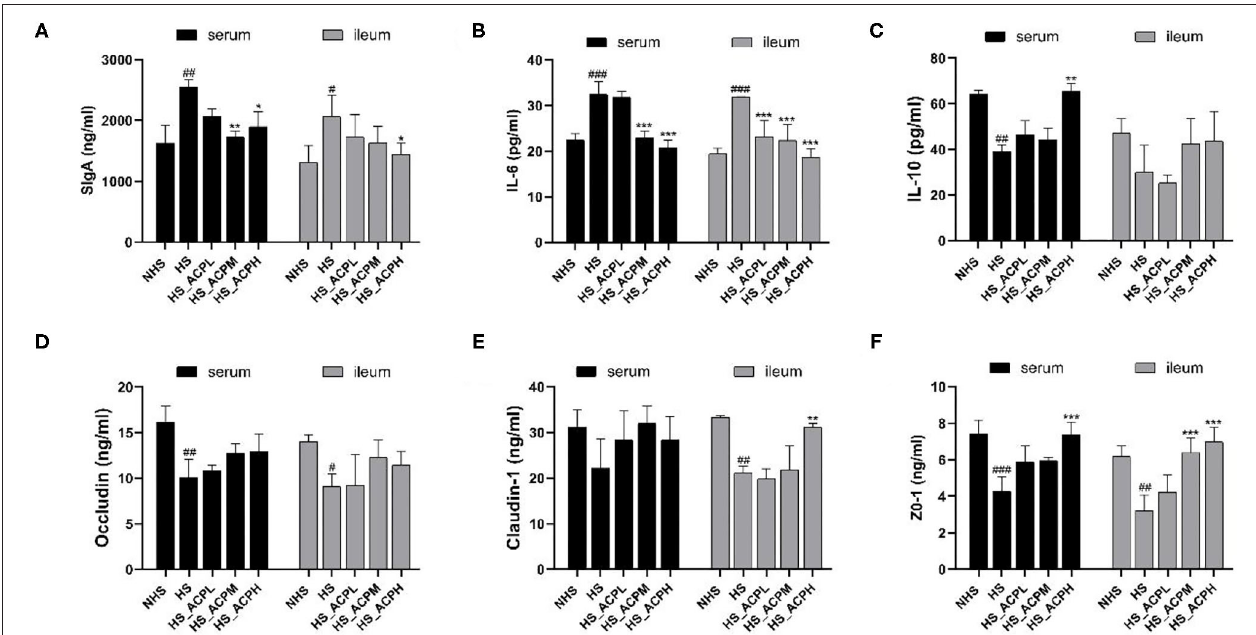
FIGURE 4 | Effects of ACP supplementation on the levels of immune factors in the serum and the ileum, and tight junction proteins. (A) secretory IgA (SIgA), (B) interleukin 6 (IL-6), (C) interleukin 10 (IL-10), (D) Occludin, (E) Claudin-1, (F) human tight junction protein 1 (ZO-1). Data are presented as the mean ± SEM. # p < 0.05, ## p < 0.01, ### p < 0.001 compared with the NHS group; * p < 0.05, ** p < 0.01, *** p < 0.001 compared with the HS